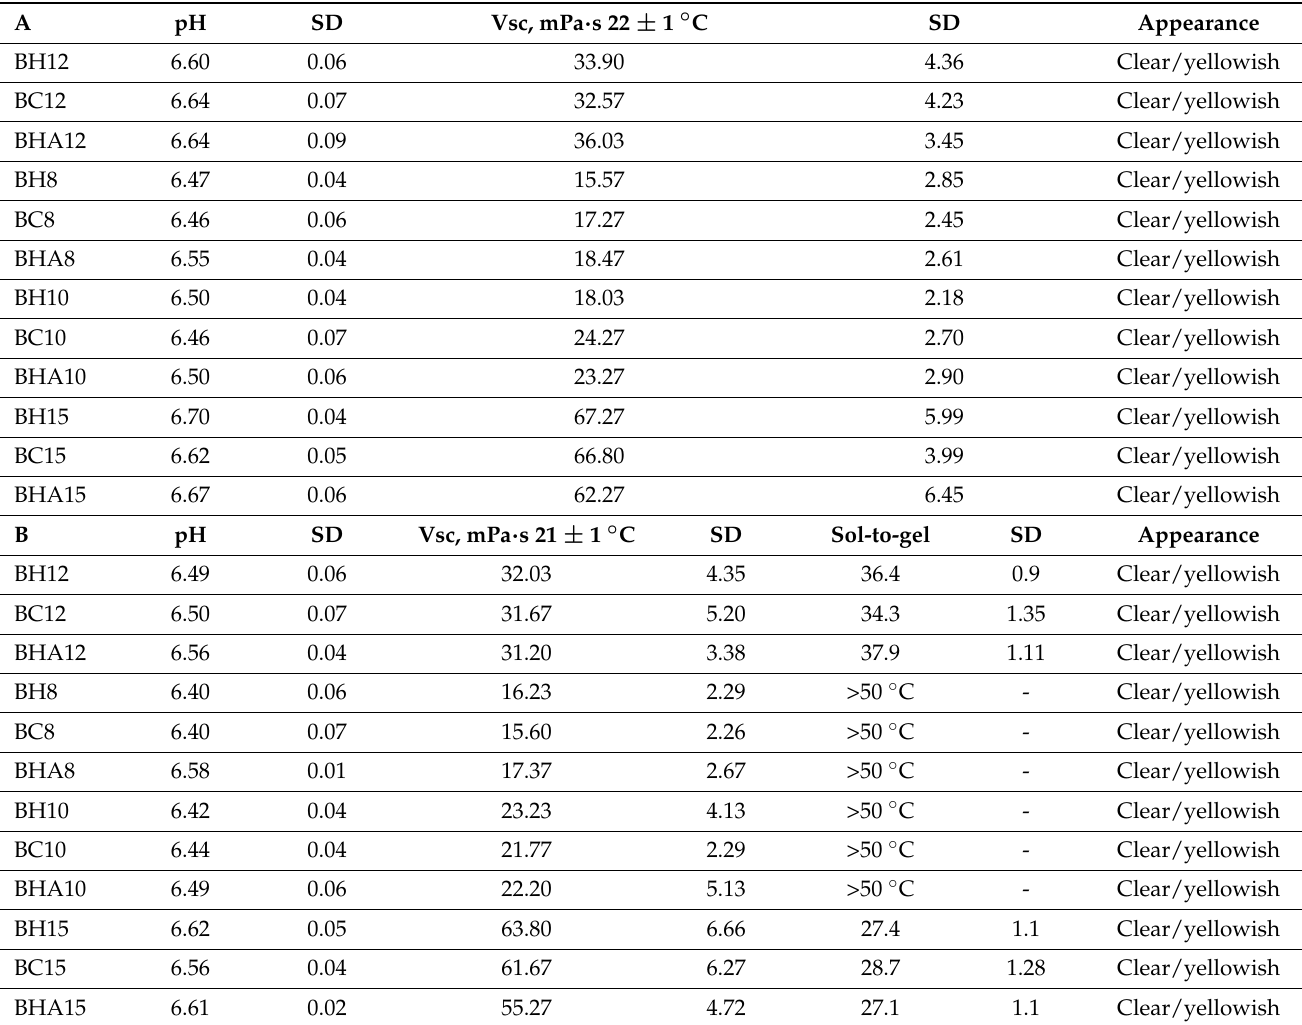
Table 3. Physicochemical properties of ophthalmic gels’ formulations with balsam poplar buds extract before (A) and after (B) sterilization (mean, SD, n =